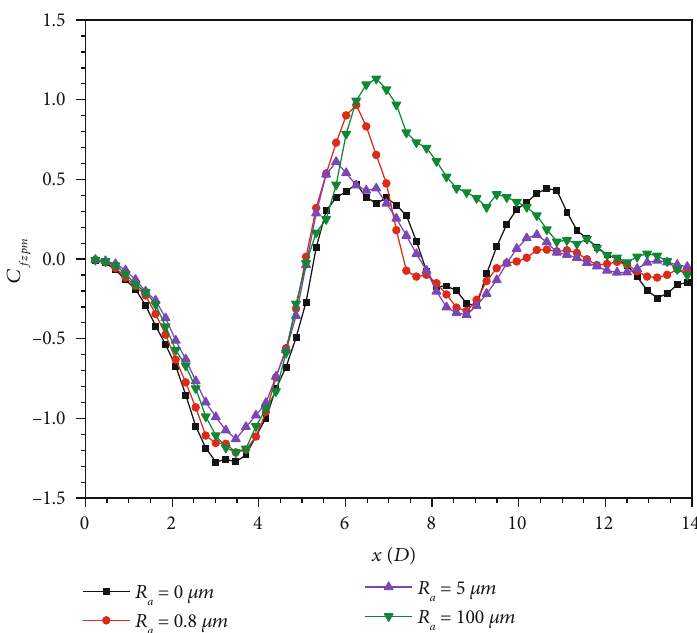
Figure 33: Axial variation of lateral force coe ffi cient per unit length.